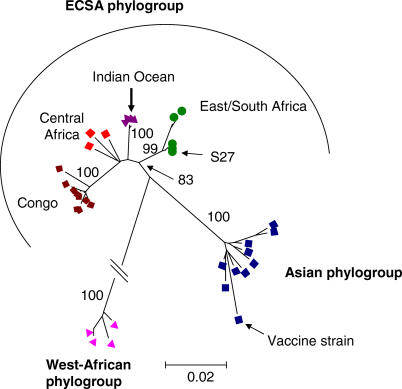
Phylogenetic Relationships among Chikungunya Isolates Based on Partial E1 Nucleotide SequencesIsolates from the Indian Ocean outbreak (Réunion, Seychelles, Mayotte, Mauritius, and Madagascar) represent a distinct clade within a large East-, Central-, and South-African (ECSA) phylogroup. Bootstrap resampling values are indicated at major nodes. The branch leading to West-African phylogroup (of length of approximately 15%) was shortened for convenience. Maximum-likelihood analysis resulted in a very similar phylogeny.